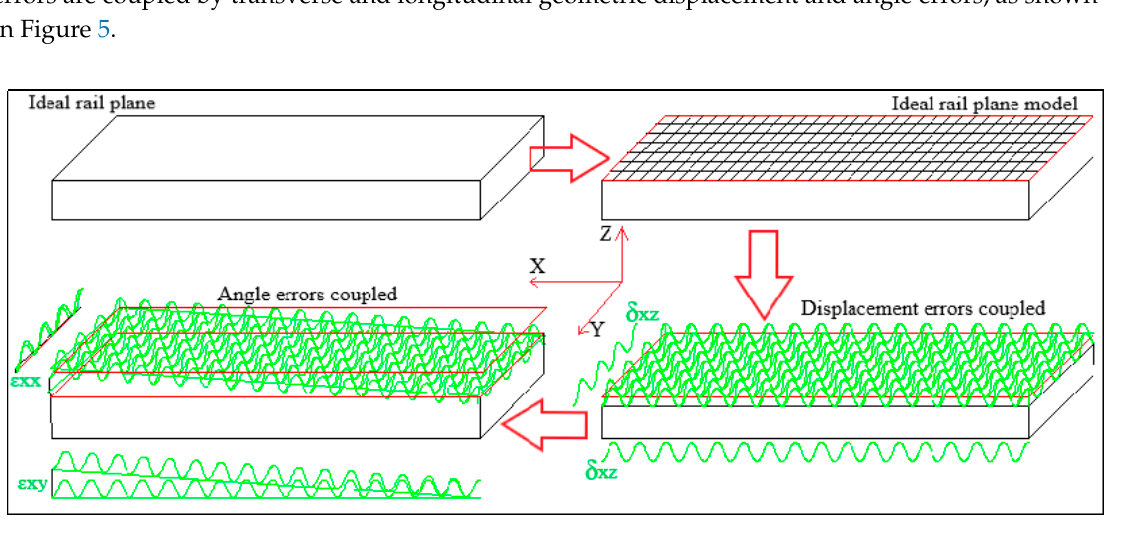
Figure 5. Geometric error coupling of the X-axis.